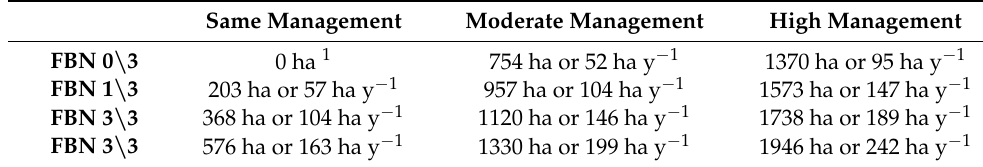
Table 2. List of fuel management scenarios, respective acronyms and increase in total fuel treated area (absolute and per year, in brackets). “FBN” stands for fuel break